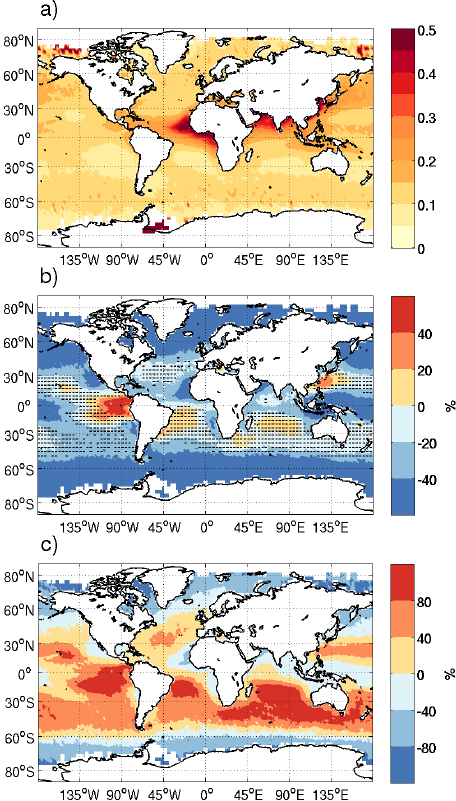
Figure 10. Comparison of modelled 5-year-mean AOD fields to 5-year-mean satellite-retrieved observations from PARASOL. The panels show (a) the observed AOD, and the normalized mean bias (with respect to PARASOL AOD) in the simulations (b) ossa-ref and (c) default-salt . The shaded area in (b) represents area where AOD from PARASOL was within the OSSA sensitivity range. The normalized mean bias ranged spatially between − 100 and 138%, and between − 100 and 168% in ossa-ref and in default-salt , re- spectively.